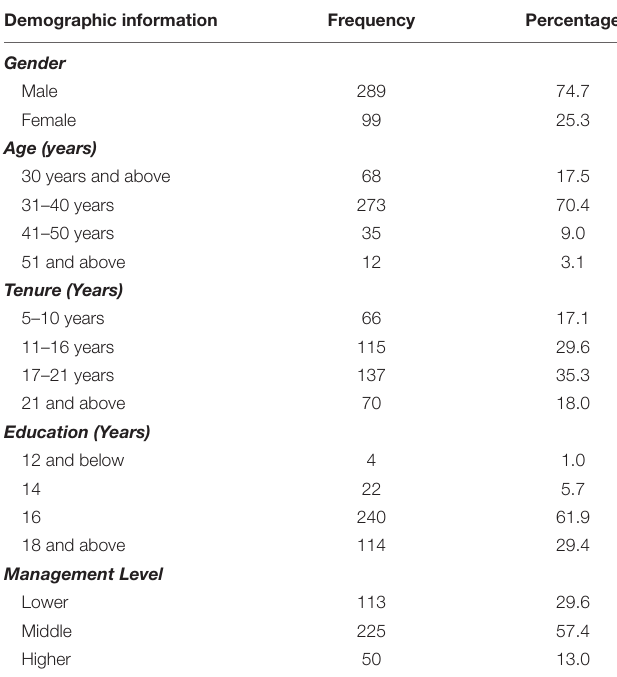
TABLE 2 | Tourists’ profile ( n =